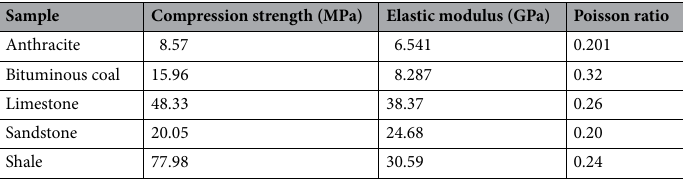
Table 1. Basic mechanical parameters of coal and rock mass.